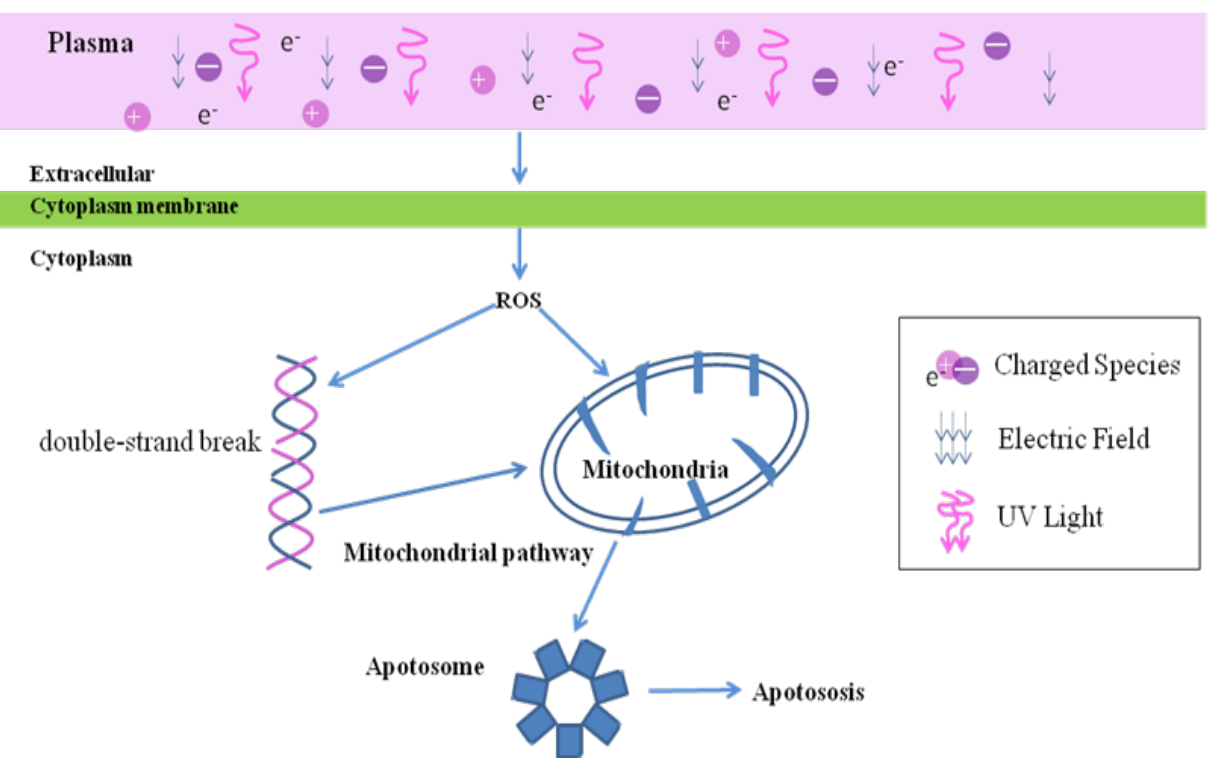
Figure 2. The oxidative stress toxicity of LTP. LTP cause the increase of intracellular ROS, which leads to DNA damage and mitochondrial damage, thus leading to the cell apoptosis.